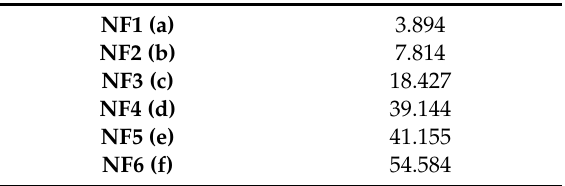
Table 5. Natural frequencies of the proposed MRPEH predicted by modal analysis using finite element analysis (FEA) (NF: natural frequency).